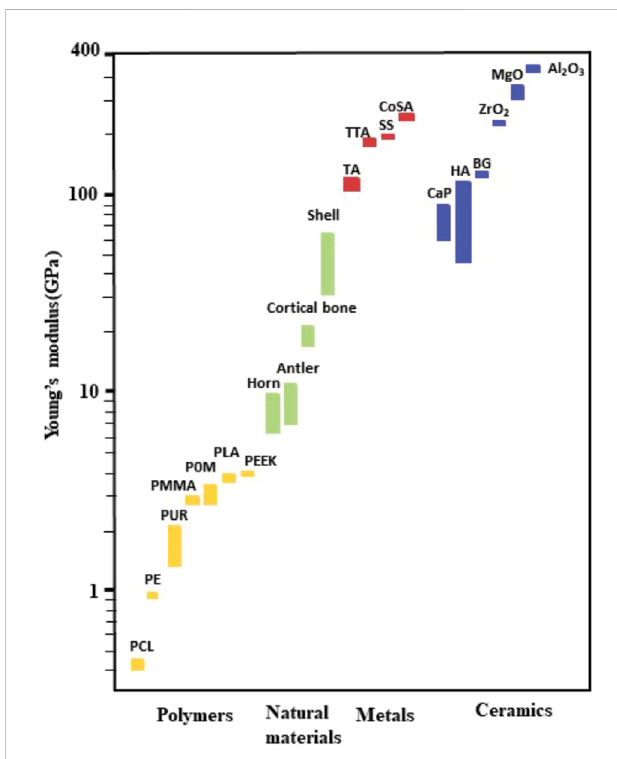
FIGURE 8 Mechanical properties (the Young ’ s modulus) of natural bone materials in comparison with those for other materials often used in biomedicine; data are based on (Orlovskii et al., 2002) and (Butscher et al., 2011).